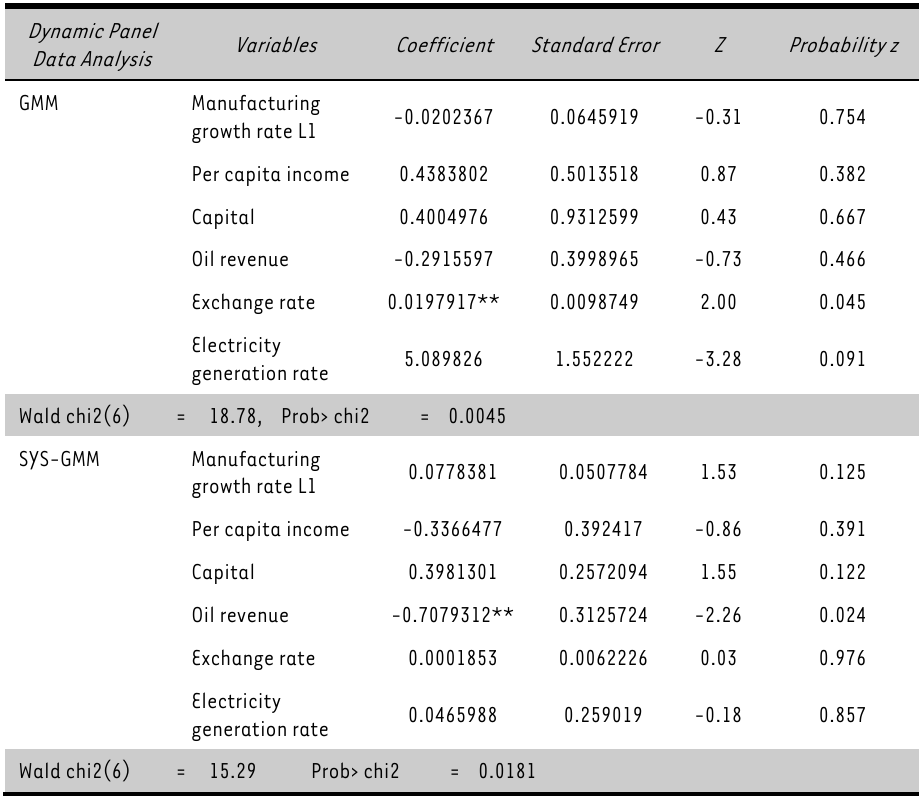
The GMM and SYS-GMM estimation results for manufacturing sector growth rate (mgr) Dynamic